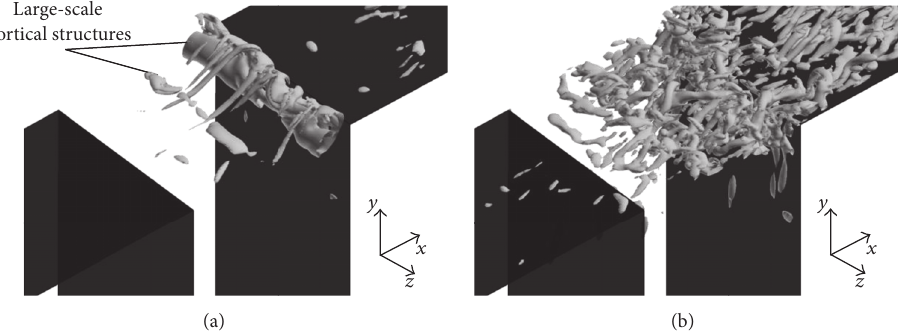
Figure 16: Instantaneous isosurfaces of second invariant of velocity tensor gradient (𝑞/(𝑈 ∞ /𝐿) 2 = 20) for cavity flows with acoustic resonance ( 𝐷/𝐿 = 2.5). (a) Cavity flow without freestream turbulence (Tu = 0.0%). (b) Cavity flow with freestream turbulence, Tu = 2.3%.